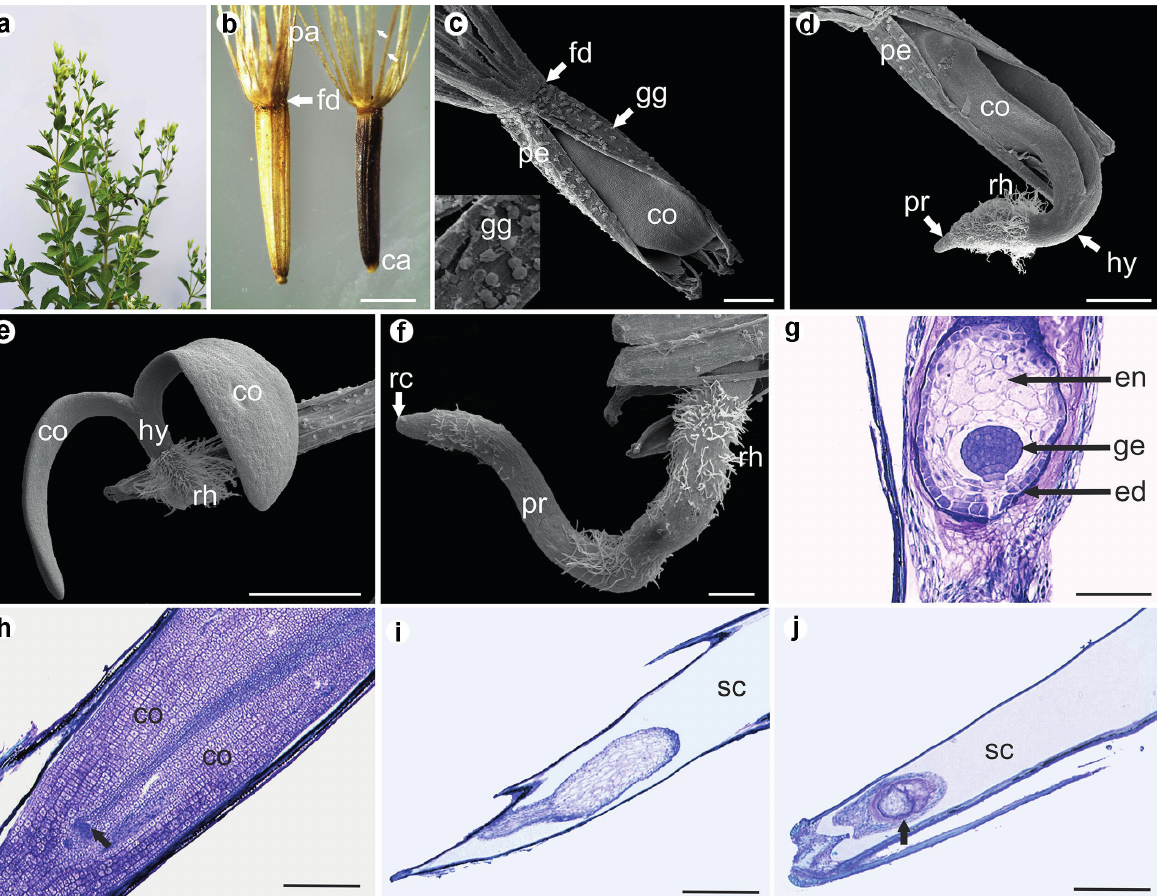
Figure 1 - Post-seminal development morphology of Stevia rebaudiana (Bert.) Bertoni. a ) General view of a mature plant with vegetative branches and inflorescences. b ) Pale and dark colored mature cypsela showing the floral disc region at the apical part of the pericarp, the pappus with rigid bristle-like awns (arrow), and the carpopodium at the basal region. c-f ) Morphological observations under scanning electron microscopy. g-j ) Anatomical aspects in light microscopy. c ) The rupture of the pericarp, revealing the cotyledons, note the globular glands on the surface of the cypsela. d ) Radicle, hypocotyl, and cotyledons emission. e ) Development of cotyledons and hypocotyl elongate and shoot apex rising. f ) Detail of the primary root, absorbing root-hairs and the root cap. g ) General view of fertile cypsela with the development of the globular embryo stage, note the nuclear endosperm in the entire seminal cavity. h ) The fertile cypsela with the well developed cotyledons, with well-defined shoot apical (arrow). i-j ) Sterile cypselas with aborted embryo (arrow in J), and an empty seminal cavity. ca = carpopodium; co = cotyledon; ed = endothelium; en = endosperm; fd = floral disk; ge = globular embryo; gg = globular gland; hy = hypocotyl; pa = pappus; pe = pericarp; pr = primary root; rc = root cap; rh = root-hairs; sc = seminal cavity. Bars: b = 2 mm; c-e = 500 µm; f = 300 µm; g = 50 µm; h = 200 µm; i-j = 500